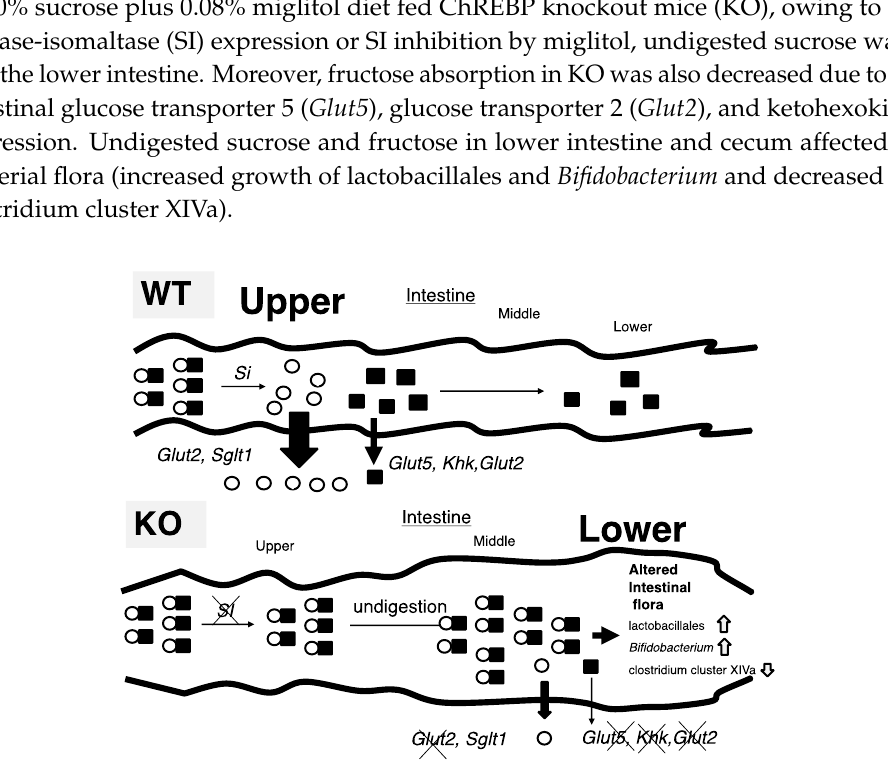
Figure 6. Schematic presentation of intestinal carbohydrate metabolism in wild-type and ChREBP knockout mice.